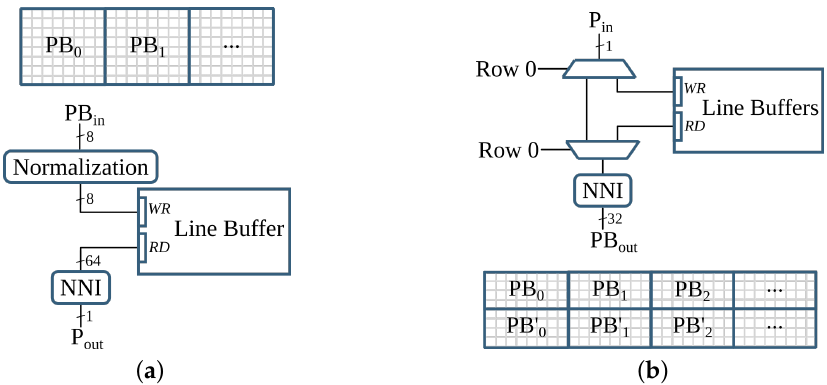
Figure 20. Custom memory access pattern for transferring pixel blocks (PBs) from external memory to the FPGA and hardware designs of ( a ) normalization and image downscale operations ( b ) image upscale operation using nearest-neighbor interpolation (NNI).